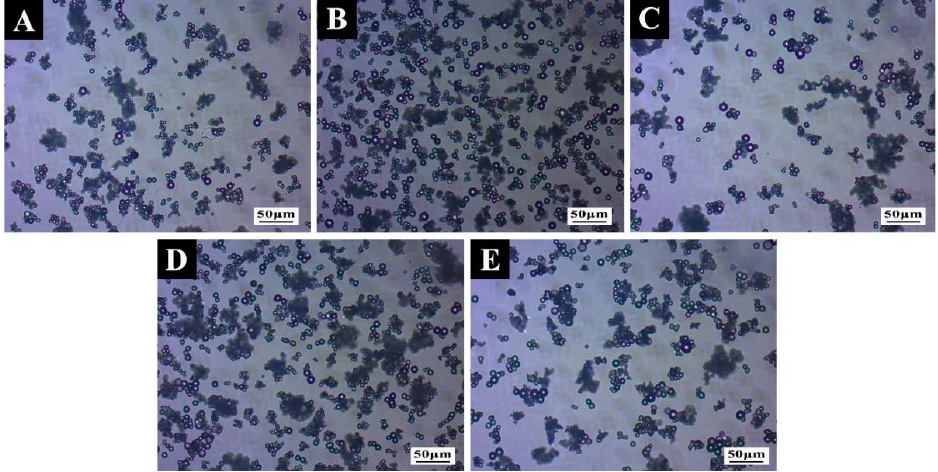
Figure 6. OM of the microcapsules under a single-factor test: ( A ) sample #10; ( B ) sample #11; ( C ) sample #12; ( D ) sample #13; ( E ) sample #14.